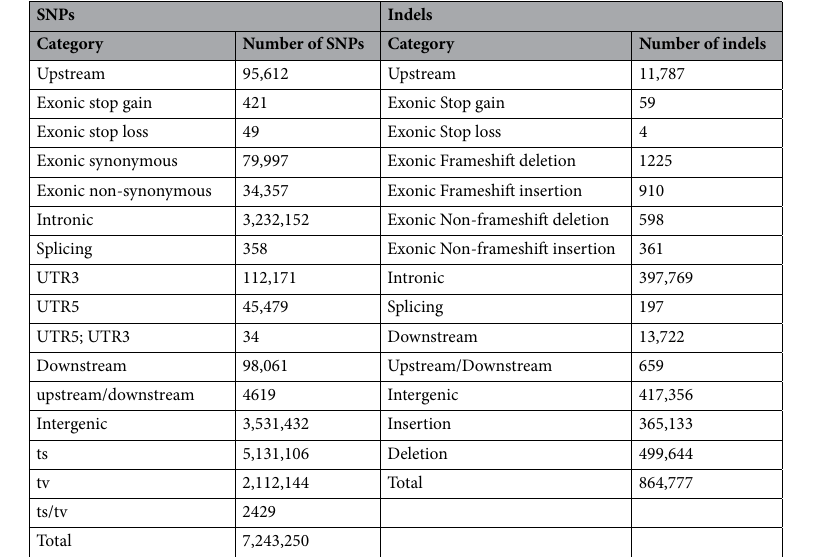
Table 1. Statistical results of SNP and indel detection and